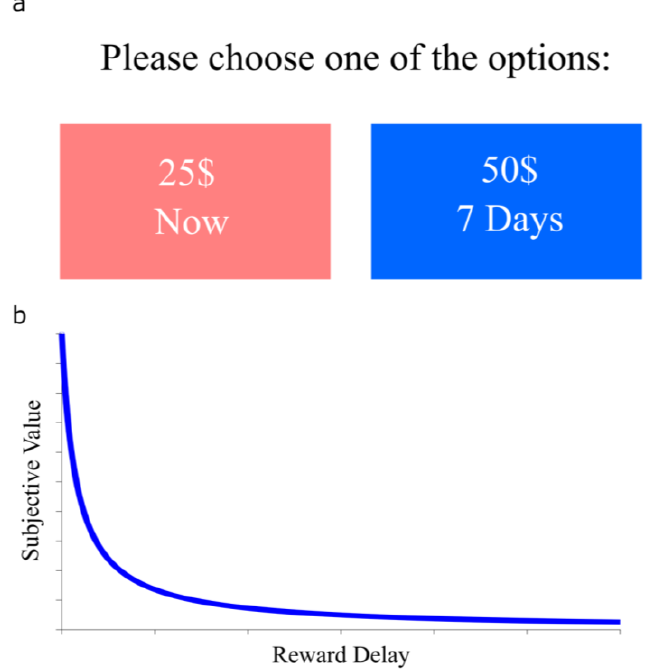
Figure 1. Intertemporal choice tasks for characterizing delay discounting in decision making. ( a ) An exemplary question from an intertemporal choice task. ( b ) The hyperbolic discounting function fitted from the indifference points obtained from the intertemporal choice task.